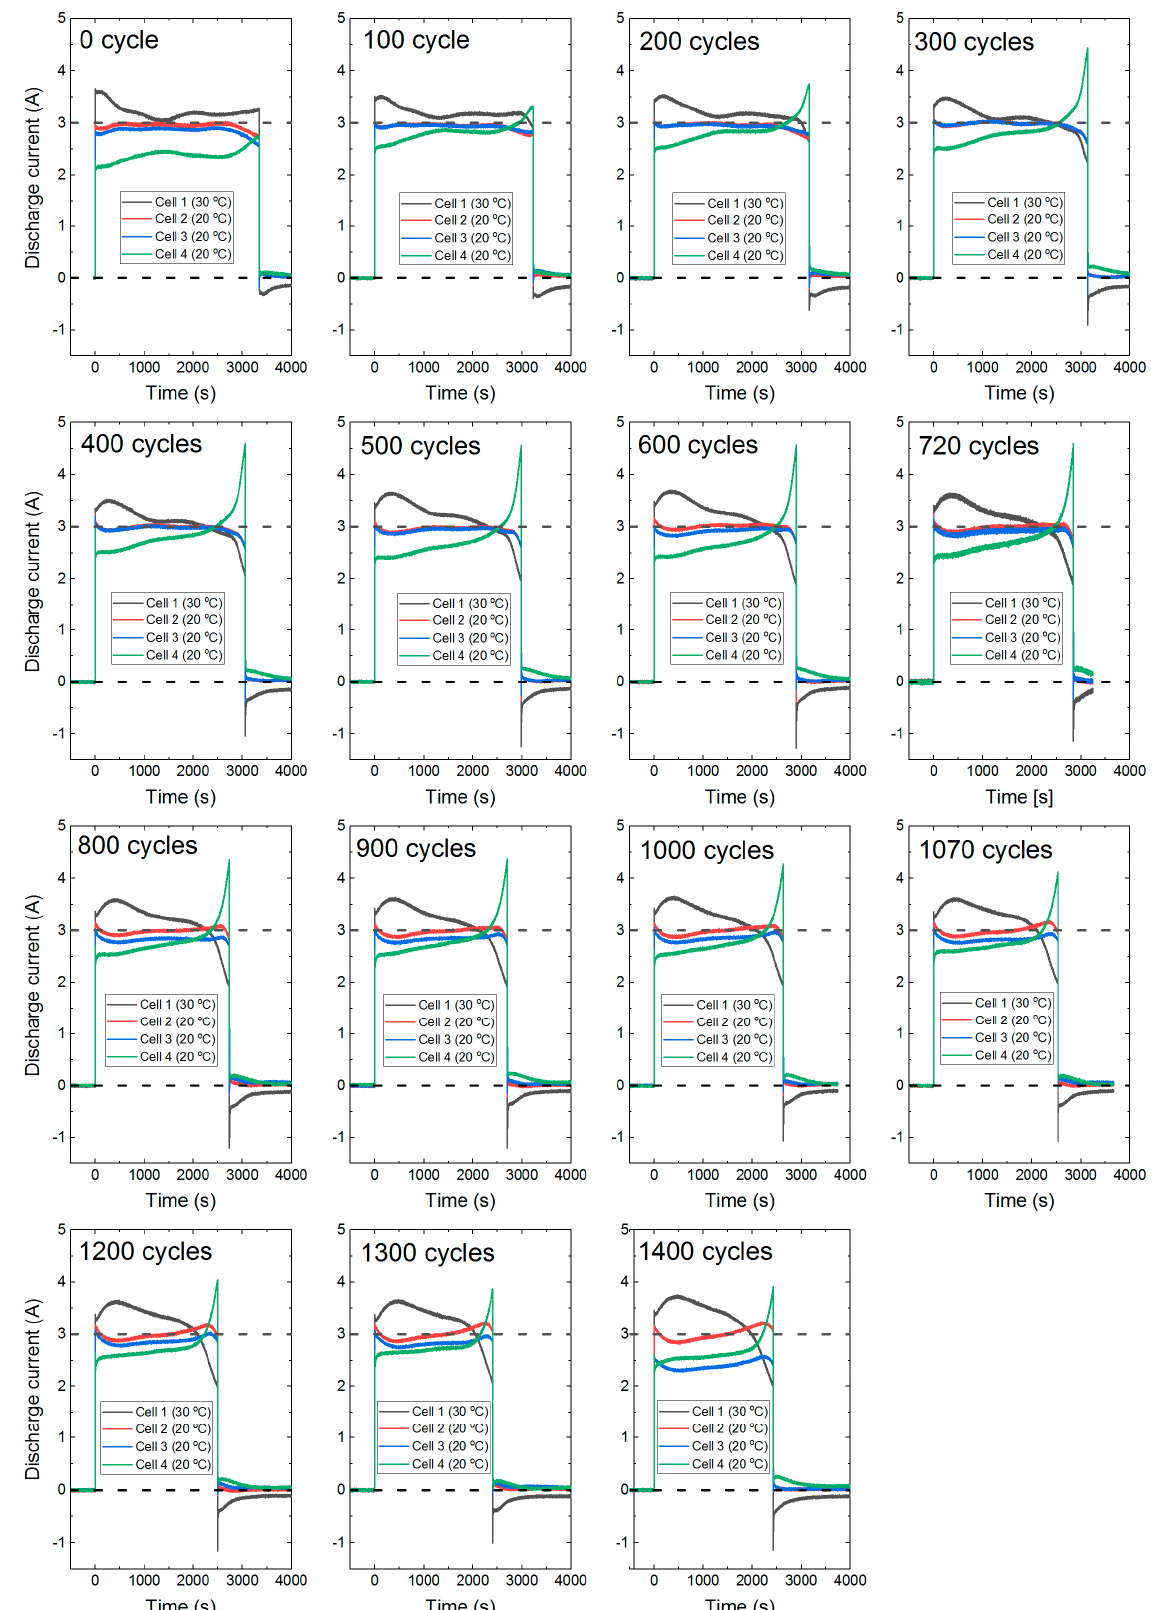
Figure 9. Current distribution in the capacity tests of the module at a discharge rate of 1C after completion of every 100 cycles. The dashed lines represent the rated current of each cell and state before discharging.